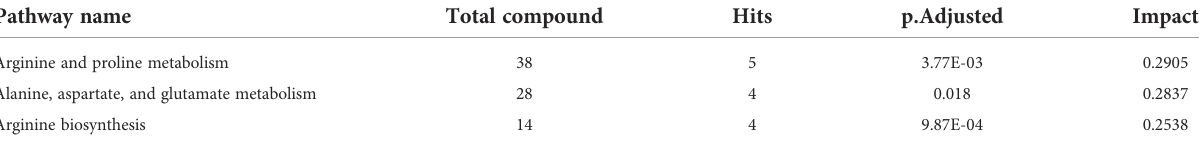
TABLE 4 Metabolic pathway enrichment for ethnicity WPI metabolome response